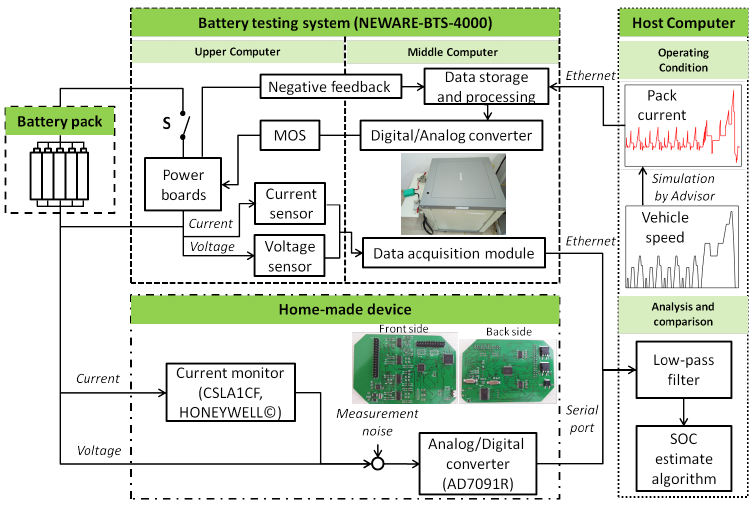
Figure 2. Block diagram of the test